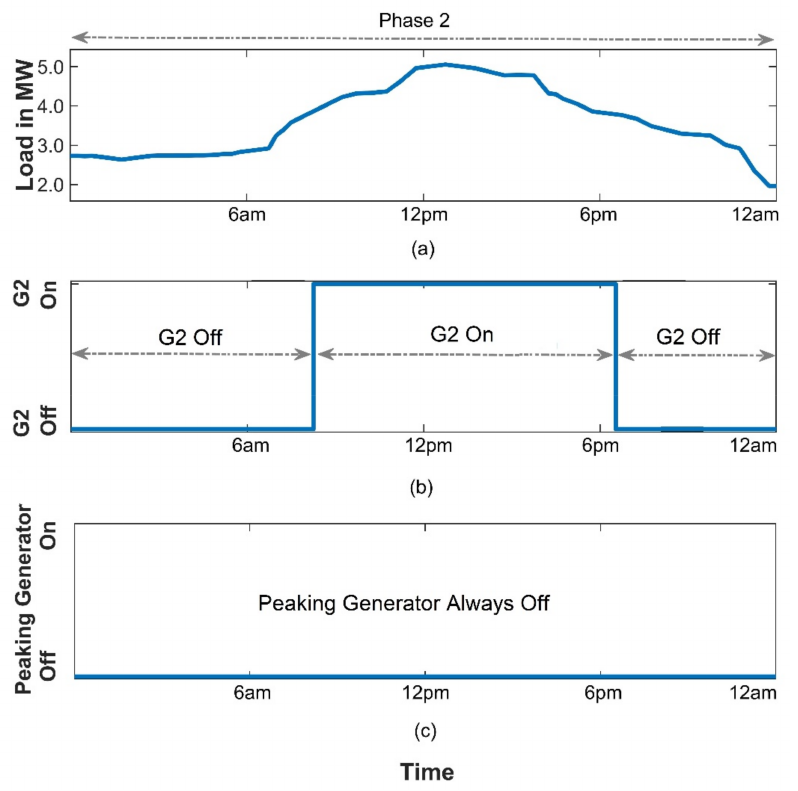
Figure 8. ( a ) Variable load profile (semester break), ( b ) Operation of economic generation dispatch, and ( c ) Operation of peaking